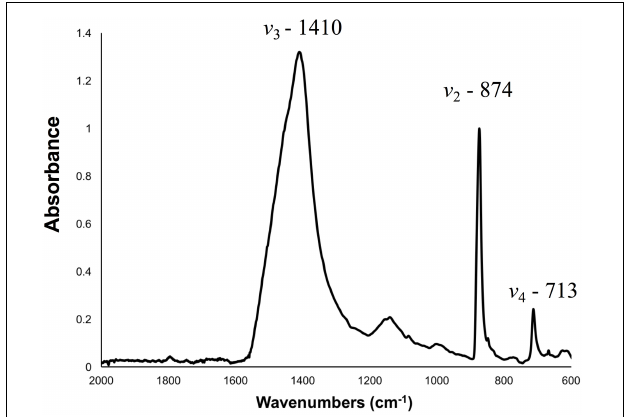
FIGURE 3 | Representative FTIR spectra of a powdered barnacle ( A. amphitrite ) shell with peaks characteristic of calcite. The ν 2 , ν 3 , and ν 4 peaks, used for crystallinity and atomic order assessments, are labeled.